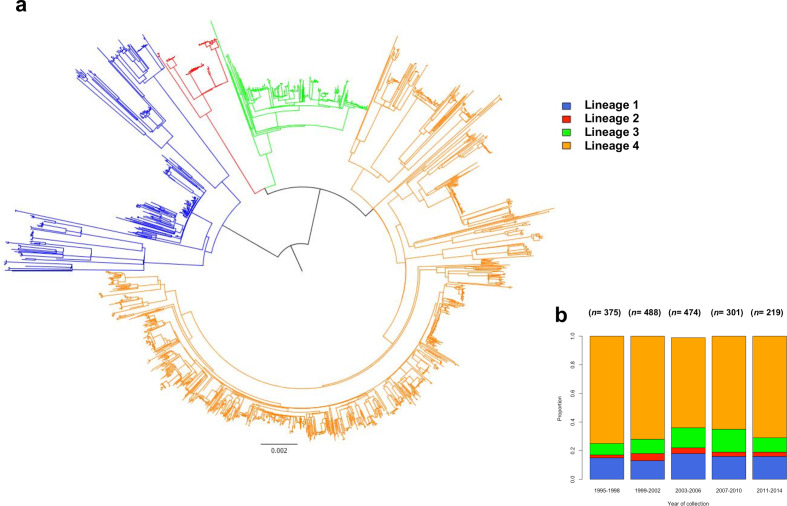
(a) Maximum-likelihood phylogenetic tree of the 1857 Karonga strains used in this study, showing lineages clustering into monophyletic groups. Lineage 1 is shown in blue, lineage 2 in red, lineage 3 in green and lineage 4 in orange. (b) The total number of sequenced cases and the proportion of strains collected, by lineage, over the study period 1995–2014 in 4-year categories.